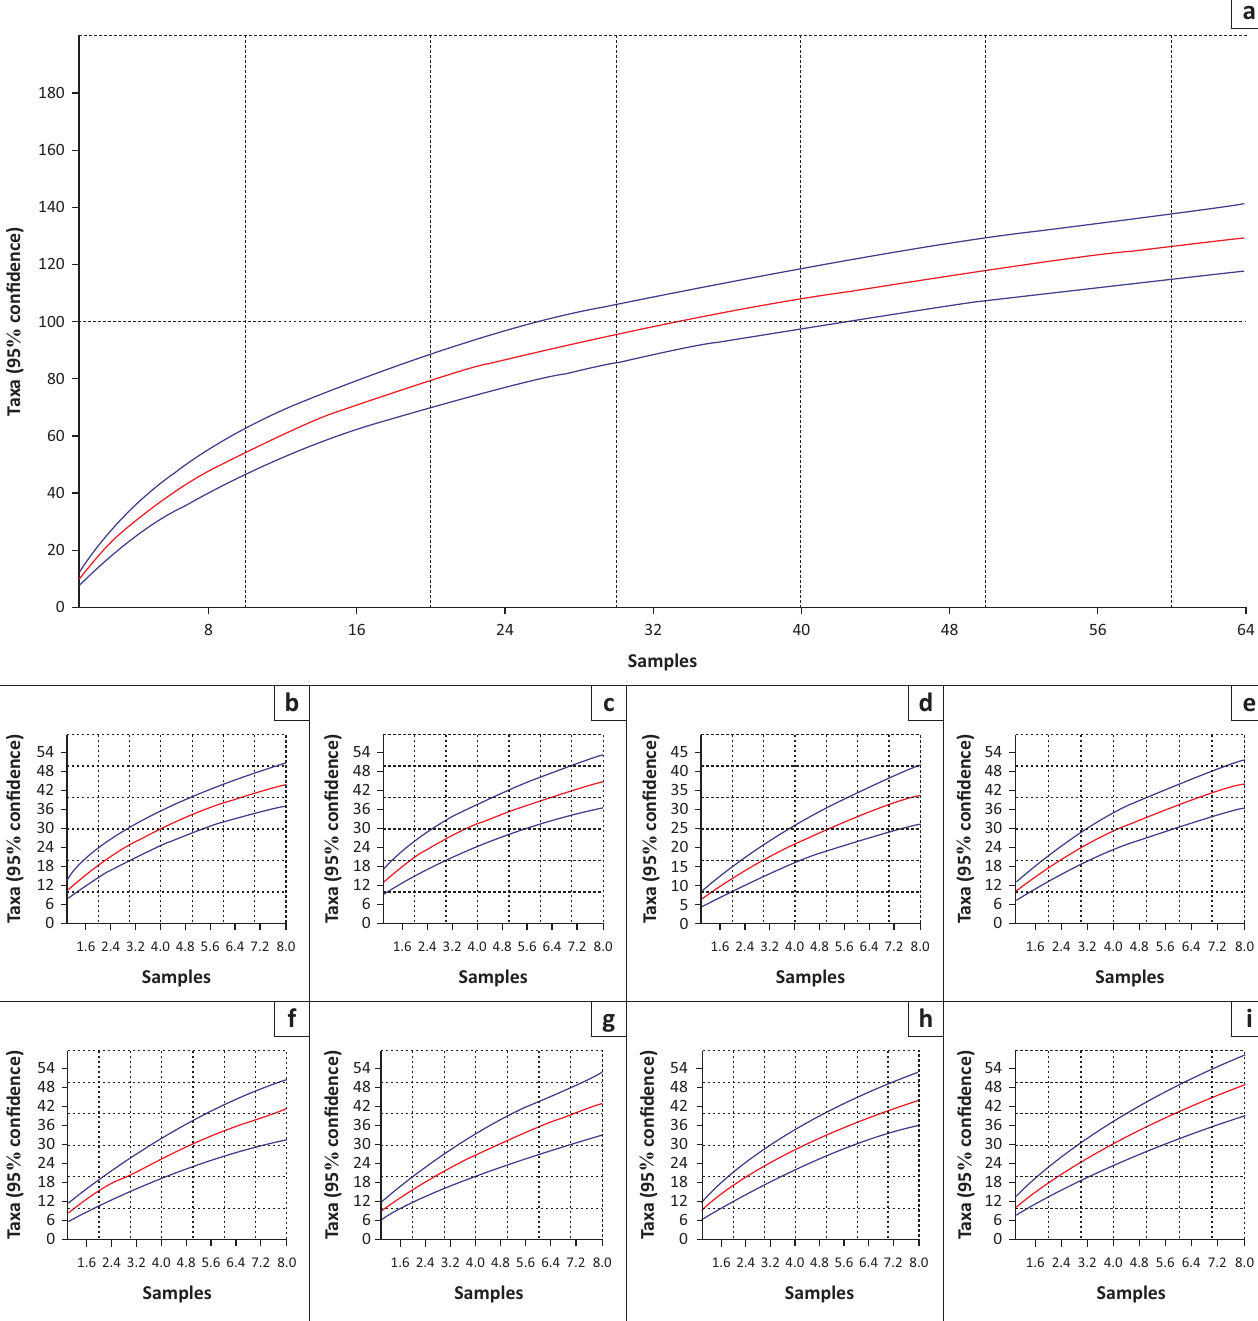
FIGURE 2: Sample rarefaction curves (Mao tau) with 95 % confidence intervals for ground-dwelling spiders sampled in the Amanzi Private Game Reserve from September 2012 to August 2013: (a) all habitats combined; (b) Searsia burchellii closed evergreen shrubland; (c) cultivated Digitaria eriantha pastures; (d) freshwater dam; (e) Olea europaea closed evergreen shrubland on northern slopes of hill; (f) O. europaea closed evergreen shrubland on plateau of hill; (g) O. europaea closed evergreen shrubland on southern slope of hill; (h) Tarchonanthus camphoratus closed evergreen shrubland; and (i) Vachellia karroo open deciduous